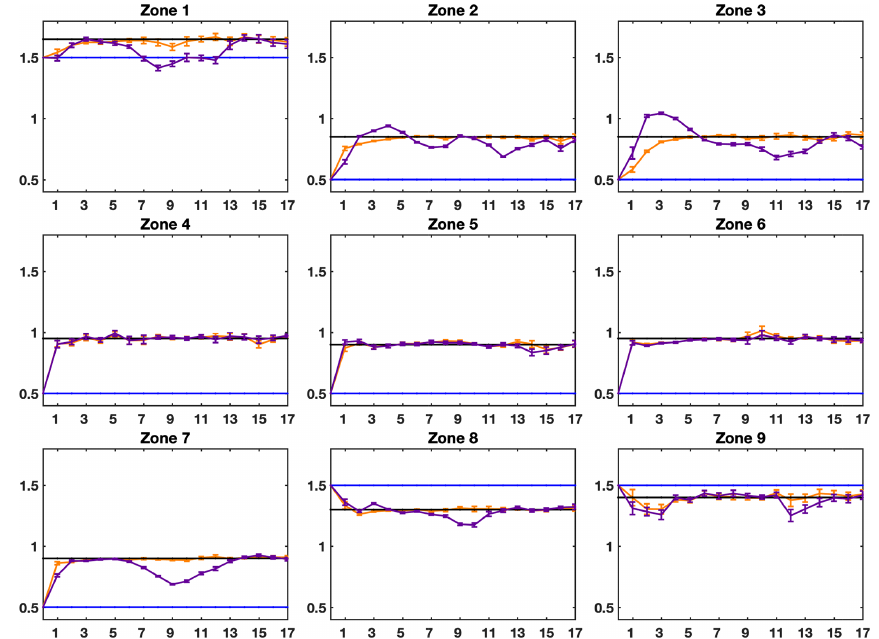
Figure 9. Control variable assimilation results for the PE2 and PE3 experiments: evolution of the ensemble-averaged analysis control variable for the PE2 experiment (orange line) and the PE3 experiment (purple line) for each zone (one zone per subplot) with respect to the assimilation cycle and compared to the corresponding true value (black line) and the openloop value (blue